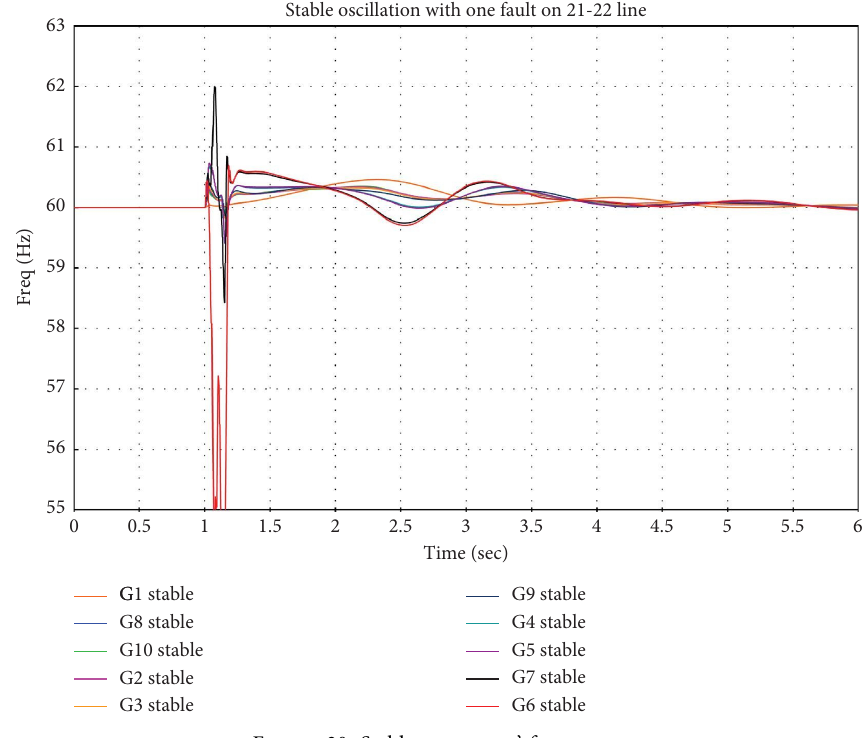
Figure 20: Stable generators’ frequency. Table 5: 39-bus system negative real part of